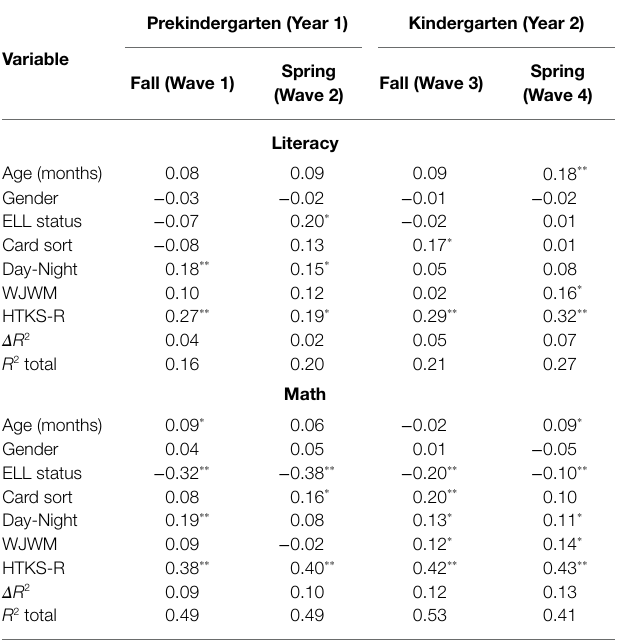
TABLE 3 | Within-timepoint Path Models Predicting Literacy and Math scores.